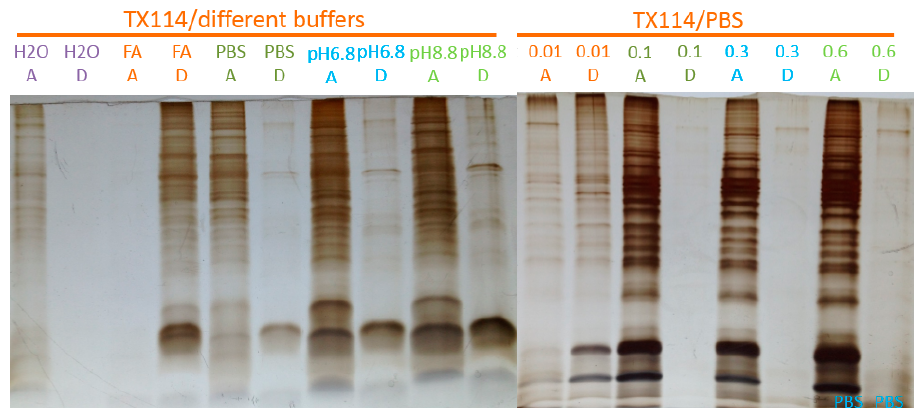
Figure 5. The effects of pH, and buffer composition on the partitioning of proteins in the detergent and aqueous phases obtained from TX-114/water two-phase separation of a membrane pre-enriched fraction of mouse myeloma cells. A and D stand for aqueous and detergent phases, respectively; pH6.8 and pH8.8 solutions are prepared by Tris buffer (0.5M) with pH adjusted by HCl; PBS stands for phosphate buffer saline; 0.01, 0.1, 0.3, and 0.6 are the v / v fraction of 1× PBS in system.